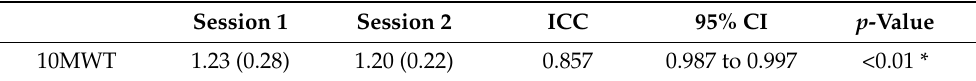
Table 1. Intra-rater reliability of the 10MWT. Session 1 Session 2 ICC 95% CI p -Value